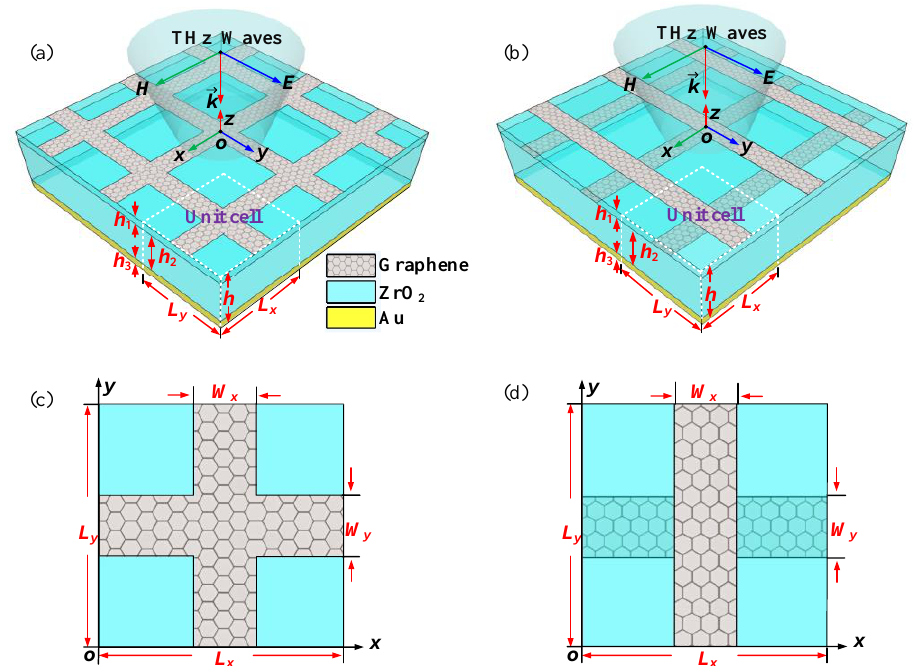
Figure 1. Schematic illustrations of the proposed frequency-reconfigurable wide-angle terahertz absorbers. ( a ) The absorber with a single-layer decussate graphene ribbon array (SLDGRA); ( b ) The absorber with double-layer decussate graphene ribbon arrays (DLDGRAs); ( c ) top view of the unit cell of the proposed absorber with SLDGRA; ( d ) top view of the unit cell of the proposed absorber with DLDGRA. The geometric parameters of the absorbers were set as L x = L y = 4 µ m, W x = W y = 0.9 µ m, h 1 = 1 µ m, h 2 = 4 µ m, h 3 = 1 µ m.